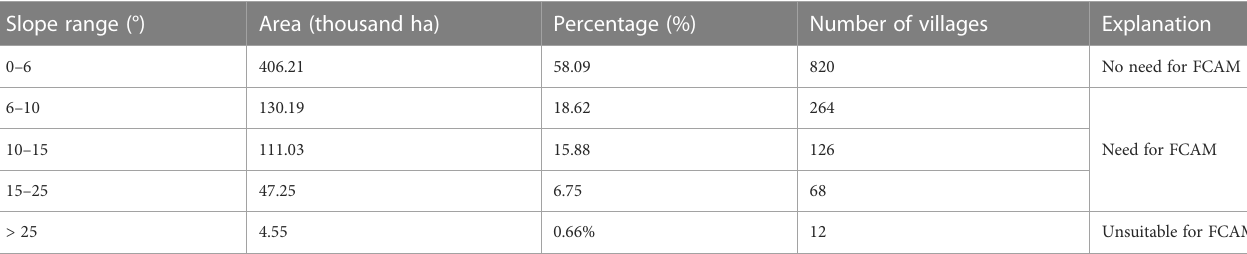
TABLE 2 Category of farmland based on slope. Slope range (°)